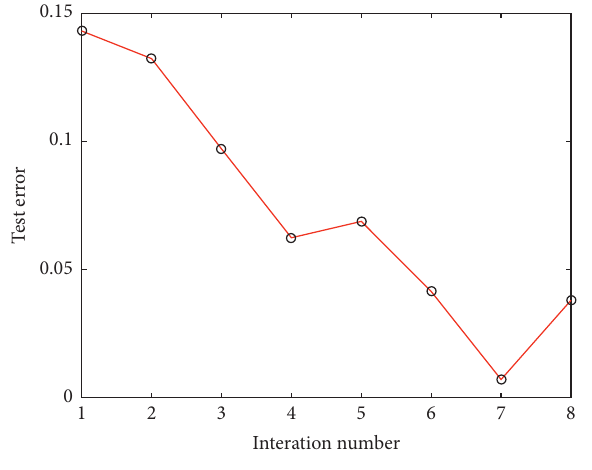
Figure 7: Test error curve of circular MSA.